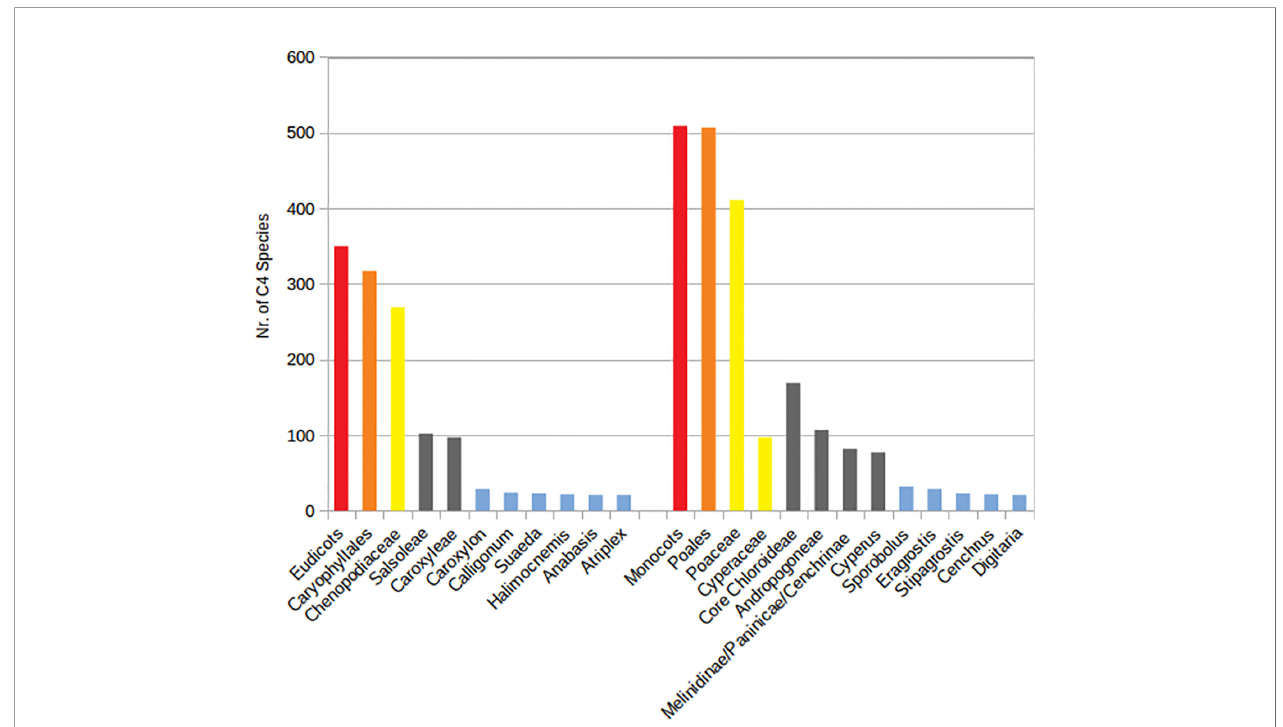
FIGURE 2 | Main taxonomic groups of Southwest (SW) Asian C 4 plants. Red — clades, orange — species richest orders, yellow — species richest families, gray — species richest independent